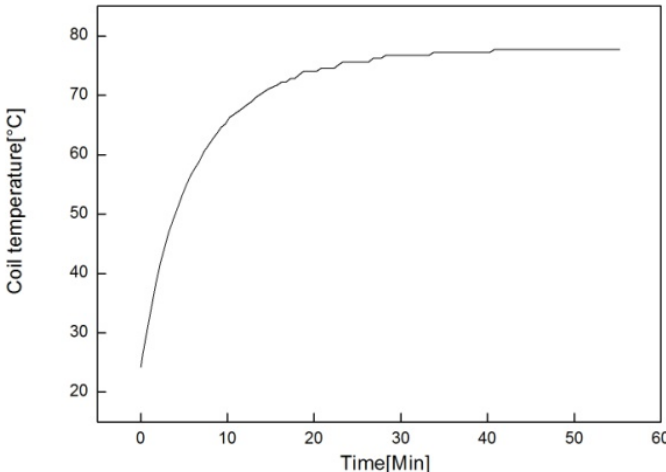
Figure 14. Measured results of coil temperature.